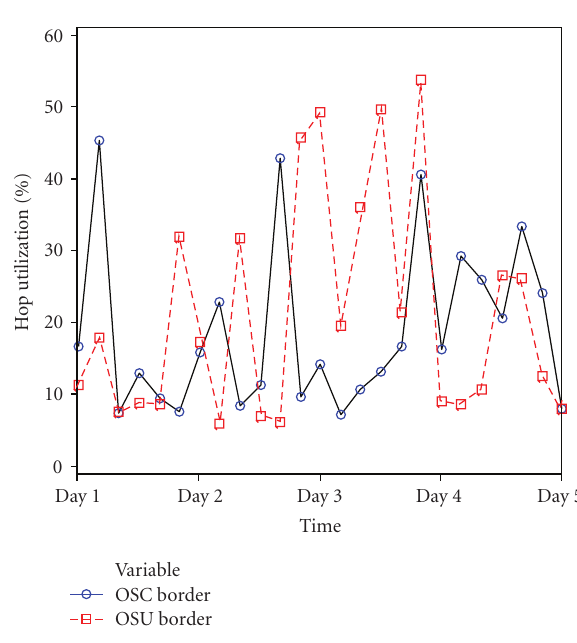
Figure 7: Border hop utilization at OSC and